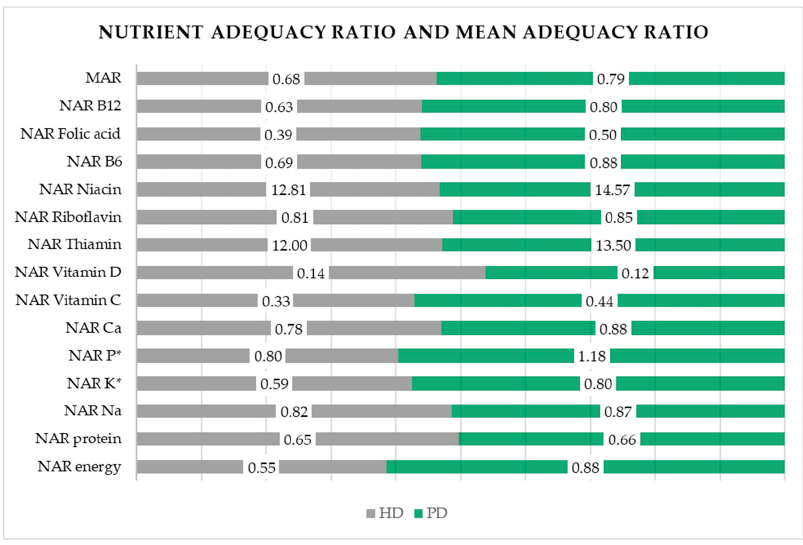
Figure 1. Nutrient adequacy ratios and mean adequacy ratio according to dialysis modality. * depicts statistically significant difference. p -values were obtained with the Chi-squared test ( p < 0.05). Abbreviations: MAR—mean adequacy ratio, NAR—nutrient adequacy ratio, Ca—calcium, P—phosphorus, K—potassium, Na—sodium.